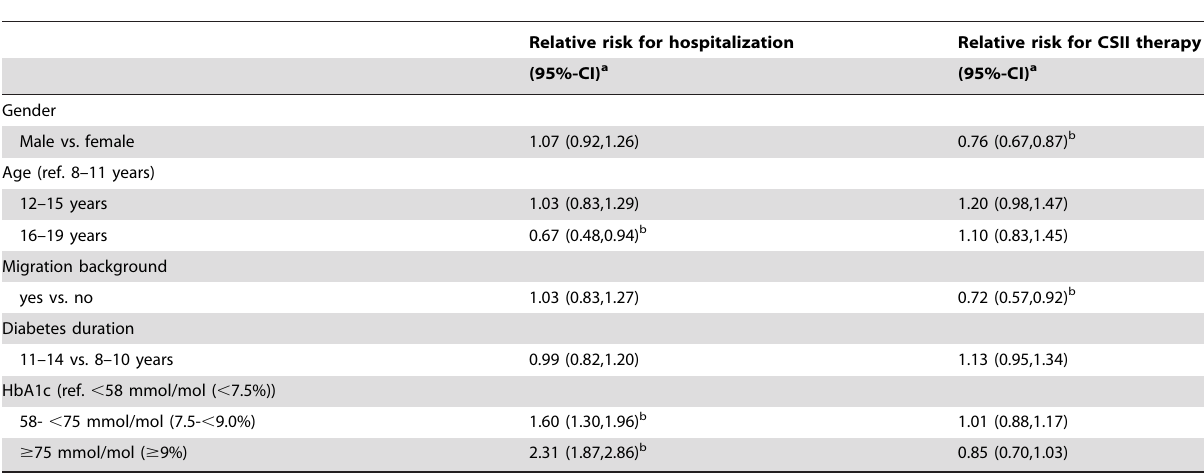
Table 3. Factors associated with inpatient care and CSII